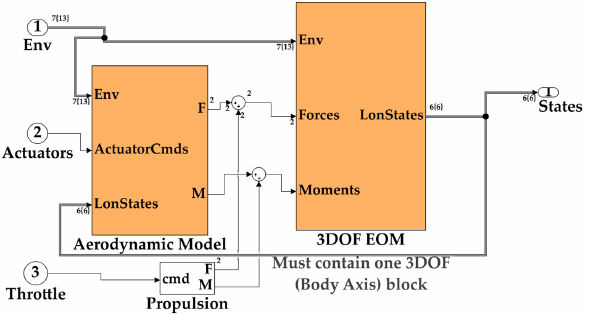
Figure 36. Block diagram used for longitudinal dynamic stability.